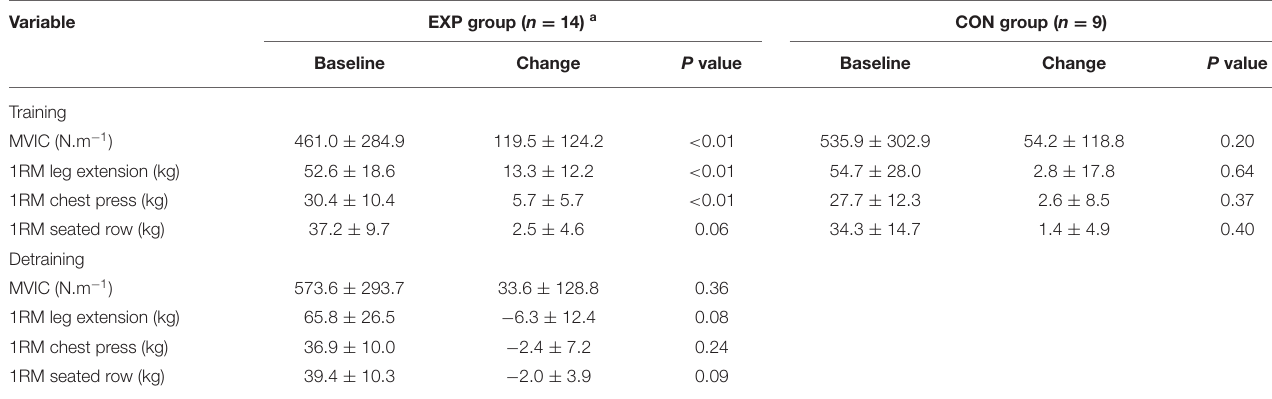
TABLE 2 | Baseline values, changes scores, and significance of change scores in both CON and EXP groups. Variable